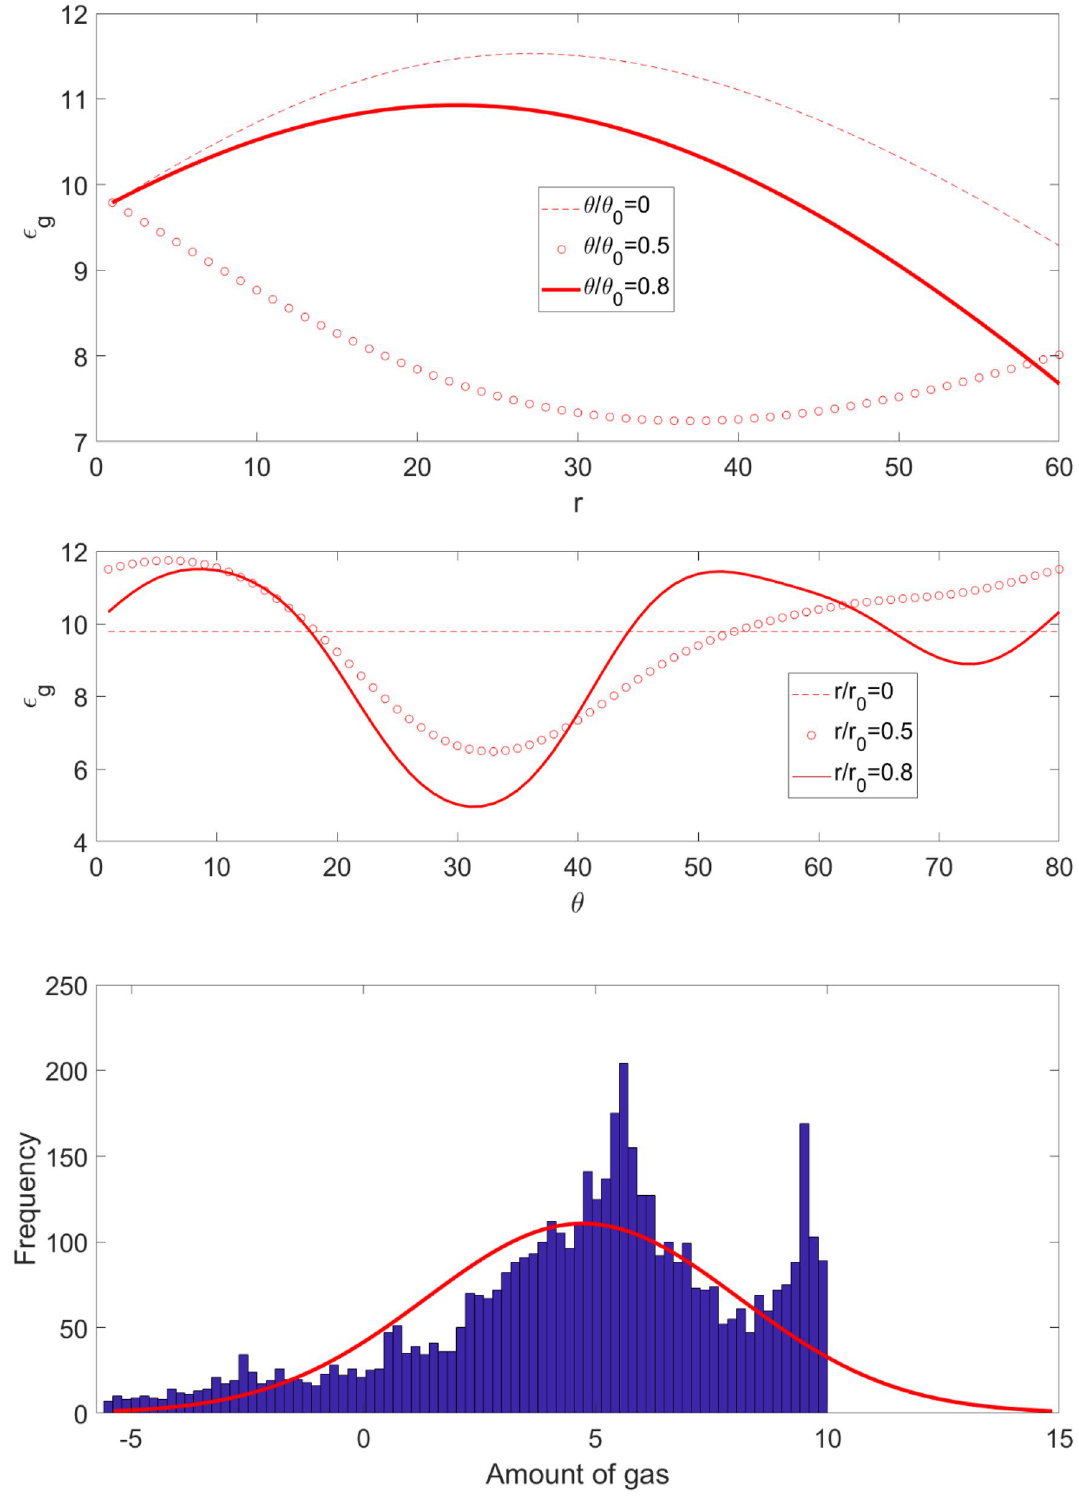
Figure 9. Gas distribution at different θ values for different r ; Number of rules for training is two. Frequency of number of elements as a function of the amount of gas in the bubble column